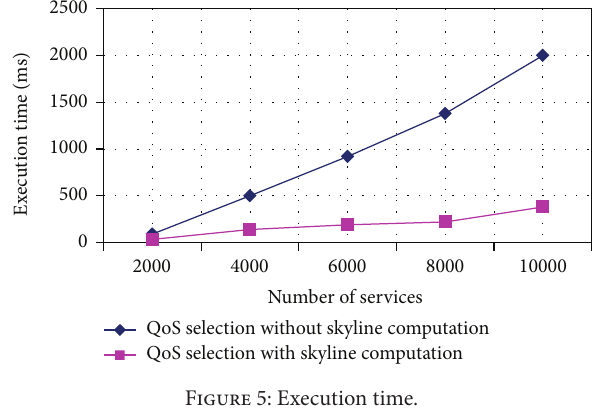
Figure 5: Execution